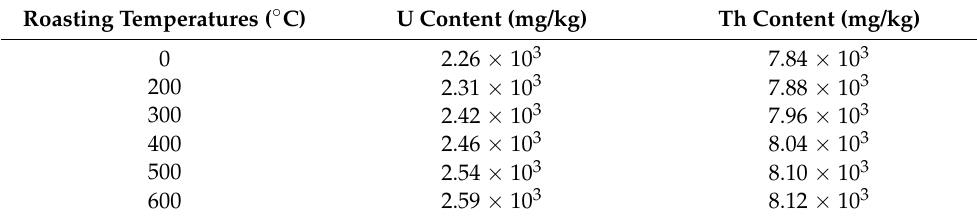
Table 6. The content of U and Th in roasted slag. Roasting Temperatures ( ◦